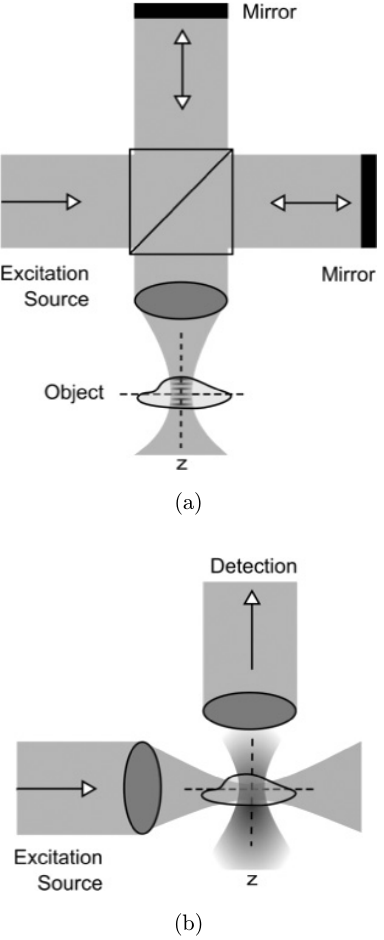
Fig. 2. Optical sectioning through interferometric scheme (a) is used in correlation gating and coherence gating (when using a broadband source) and (b) angular gating as explained in Sec.